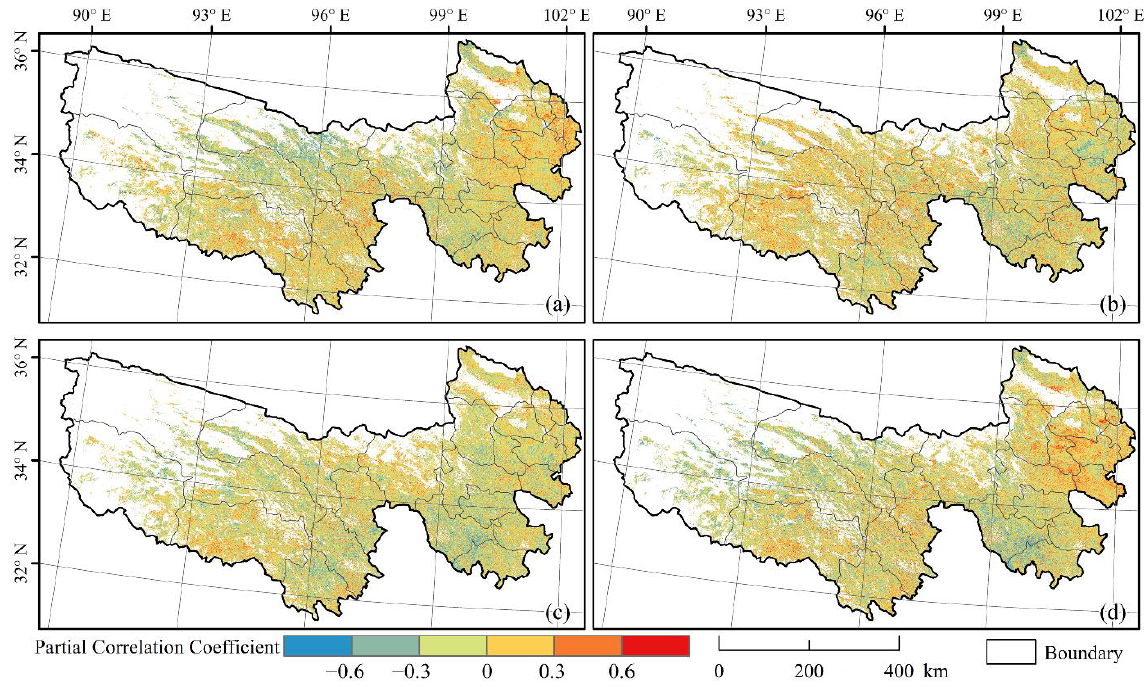
Figure 18. Spatial distribution of the partial correlation coefficients between the EOS of the vegetation and sunshine duration in August ( a ), September ( b ), October ( c ) and August – October ( d ) in the Three-River headwaters region.